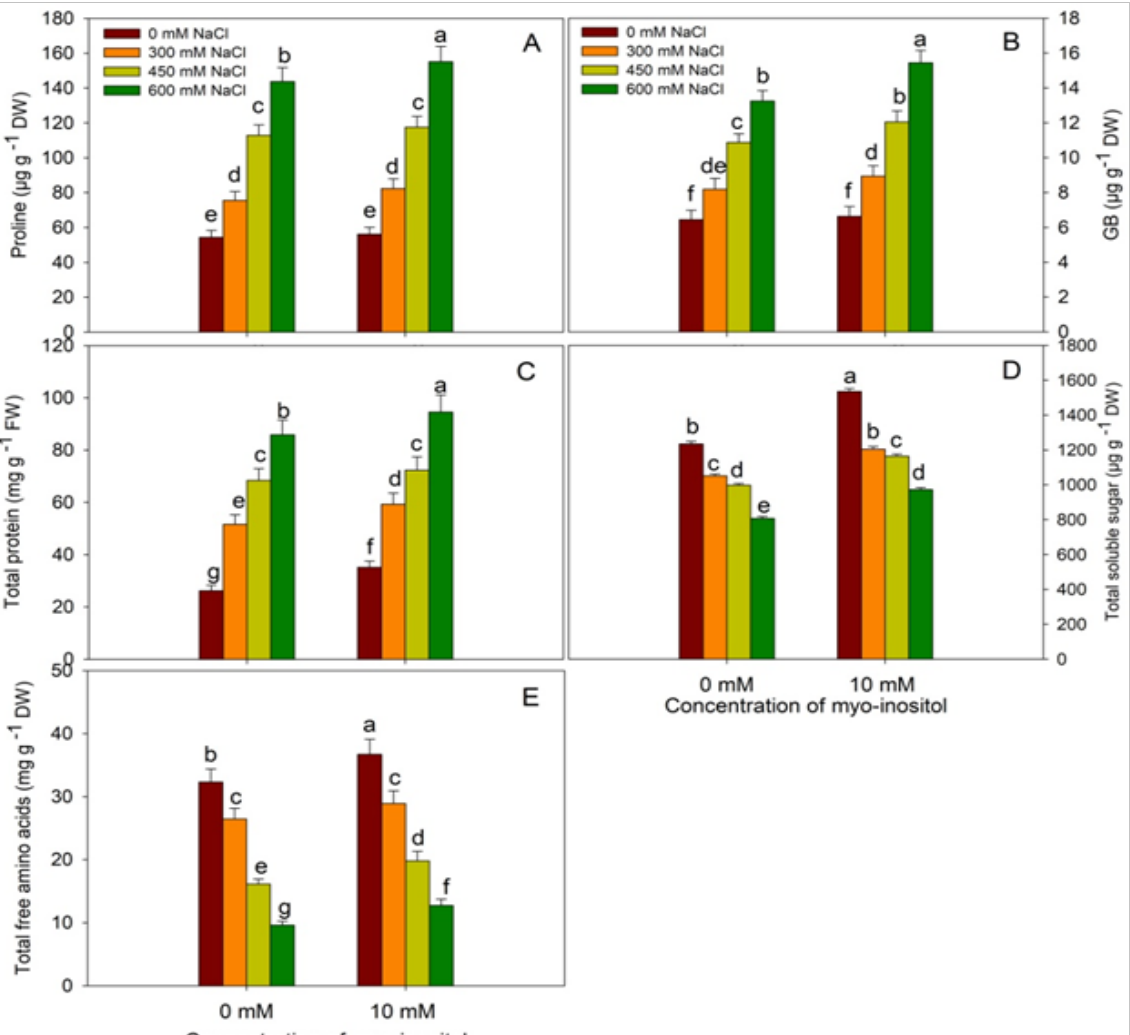
Figure 5. Effect of different salinity (300, 450, and 600 mM NaCl) concentrations with and without exogenous application of myo-inositol (10 mM) on changes in osmolyte concentration in Quinoa ( Chenopodium quinoa L. var. Giza1). Data expressed as ( A ) total proline content; ( B ) glycine betaine (GB); ( C ) total protein; ( D ) total soluble sugars (TSS), and ( E ) total free amino acids. Values are mean ( ± SE) of four replicates, and different letters represent significant differences at p ≤ 0.05.